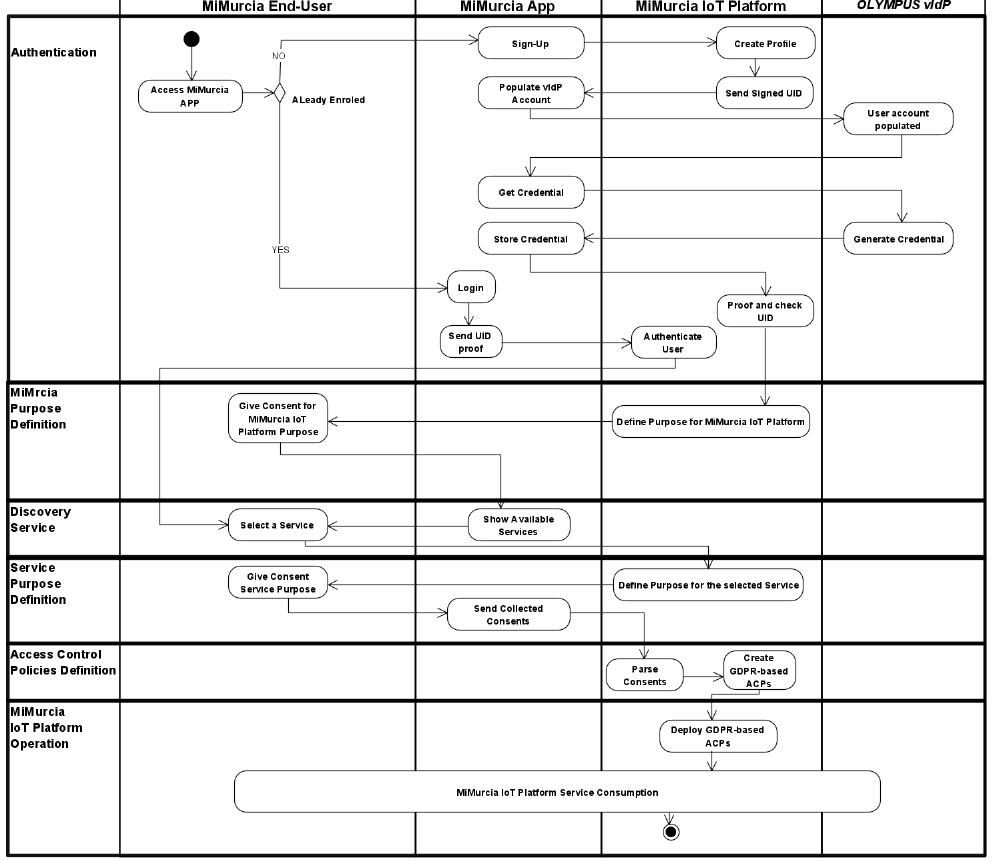
Figure 9. Sign-Up and Login to MiMurcia IoT